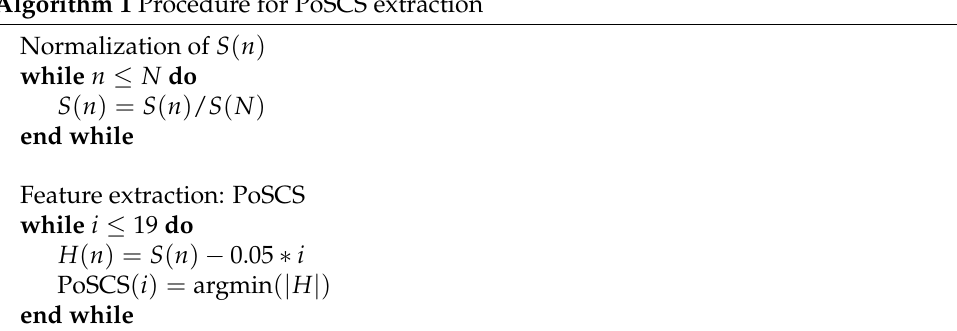
Figure 3. Result of the SCS function using the EMG signal. Algorithm 1 Procedure for PoSCS